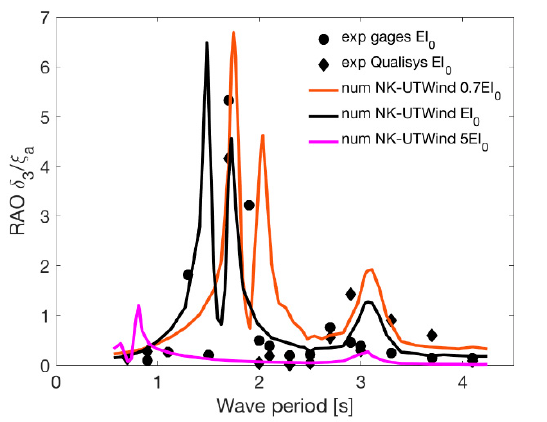
Figure 17. RAO punctual displacement due to the elastic deformation at the column bottom result comparisons between the experiment and NK-UTWind numerical calculation for different structural rigidities.